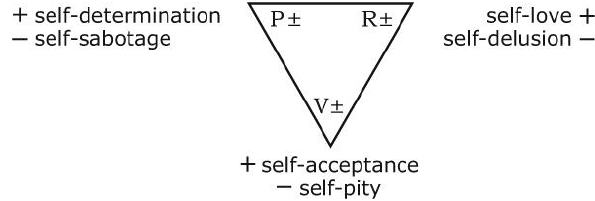
Figure 8: The inner-self drama triangle +/- Figure 8 spells out the treatment possibilities